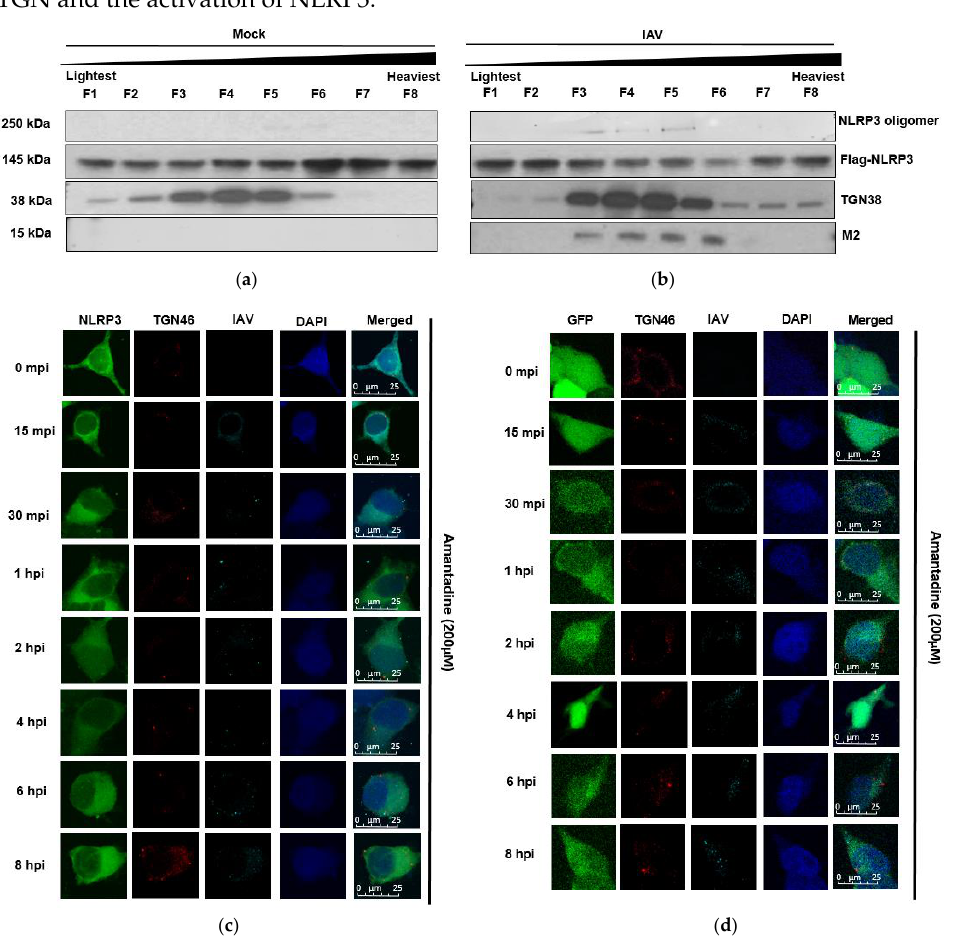
( f ) Figure 3. M2 Protein influences dTGN formation before NLRP3 recruitment. HEK293T cells were transfected with Flag-NLRP3 for 48 h before being mock infected ( a ) or infected with Hf09 WT at MOI of 5 for 12 h ( b ). The cells were harvested and fractionated to isolate the light membrane